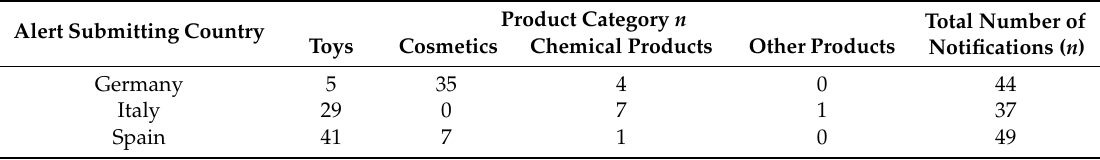
Table 1. Number of initial notifications by product category for the three main reporting countries (2005–2017).